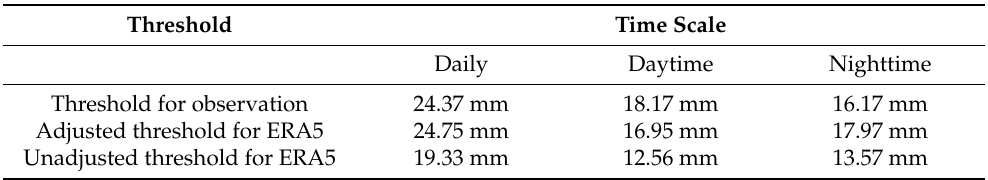
Table 1. The 90th-percentile threshold for surface observational stations and the adjusted and unadjusted threshold for station-corresponding ERA5 grid